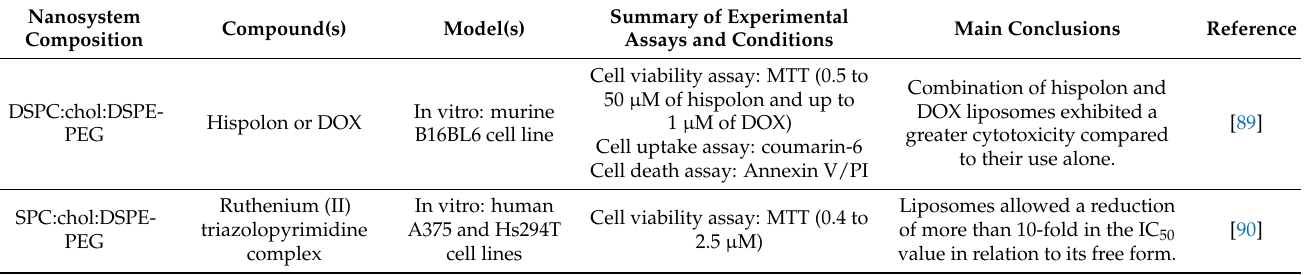
Table 1. In vitro and in vivo assessment of the therapeutic potential of different liposomal formula- tions in melanoma